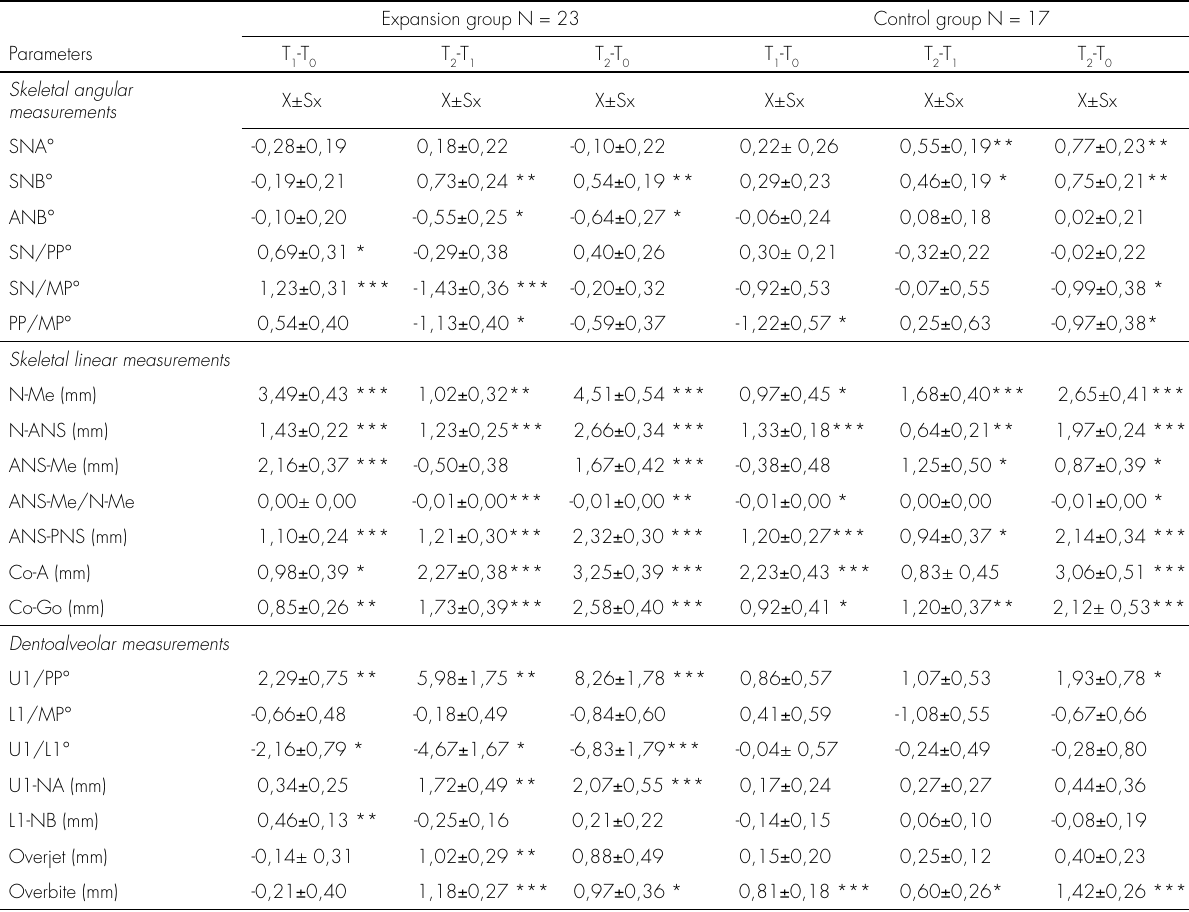
Table IV. The changes in lateral radiographic measurements during different